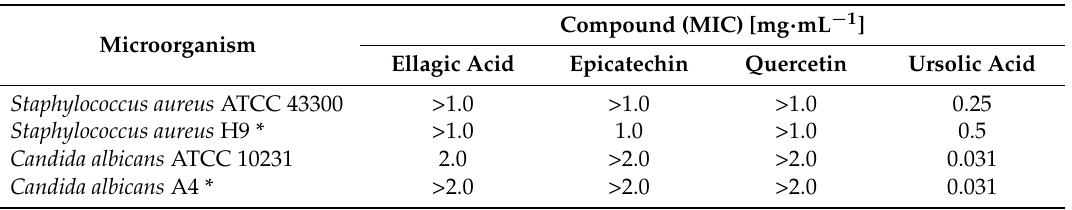
Table 3. The antimicrobial activity of reference phytochemicals. Minimal inhibition concentration (MIC) measured by broth microdilution